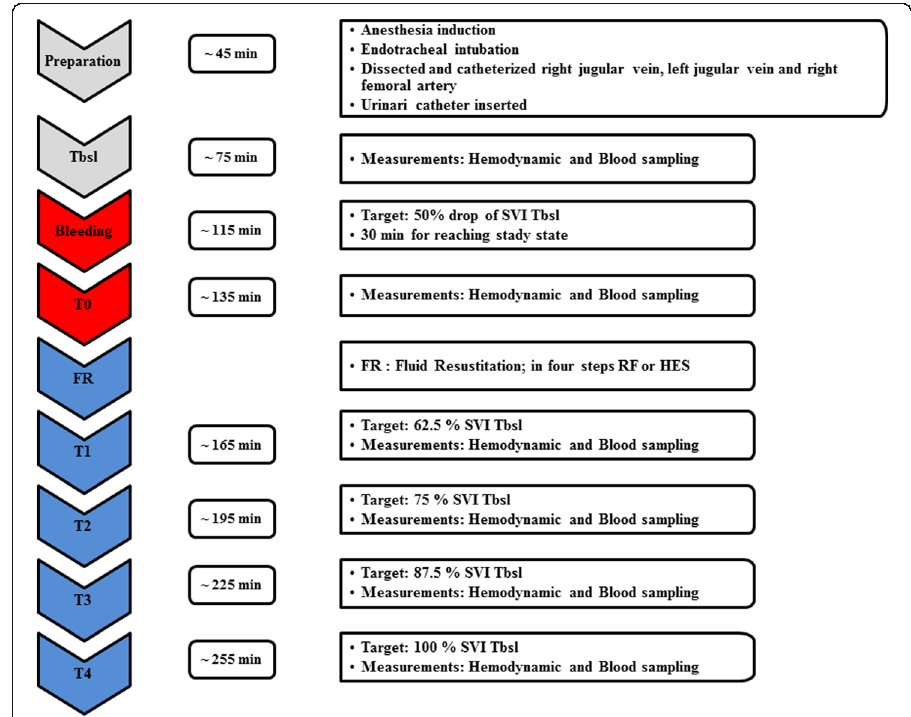
Fig. 1 Schematic flowchart illustrating the experimental protocol. After baseline measurements, animals were bled until the stroke volume index (SVI) decreased by 50% ( T 0 ). Then, measurements were repeated and the animals were randomized into the balanced crystalloid (Ringerfundin®, RF B. Braun AG) or colloid (Voluven®, HES) groups. The difference of the SVI T bsl − SVI T 0 was divided into four equal steps ( T 1 – 4 ) and i.v. fluids were administered to reach these target